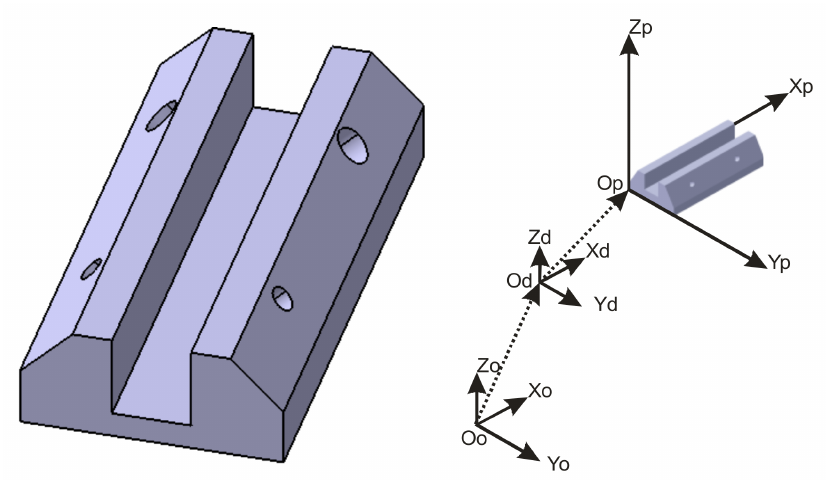
Figure 1. The generic part and its reference